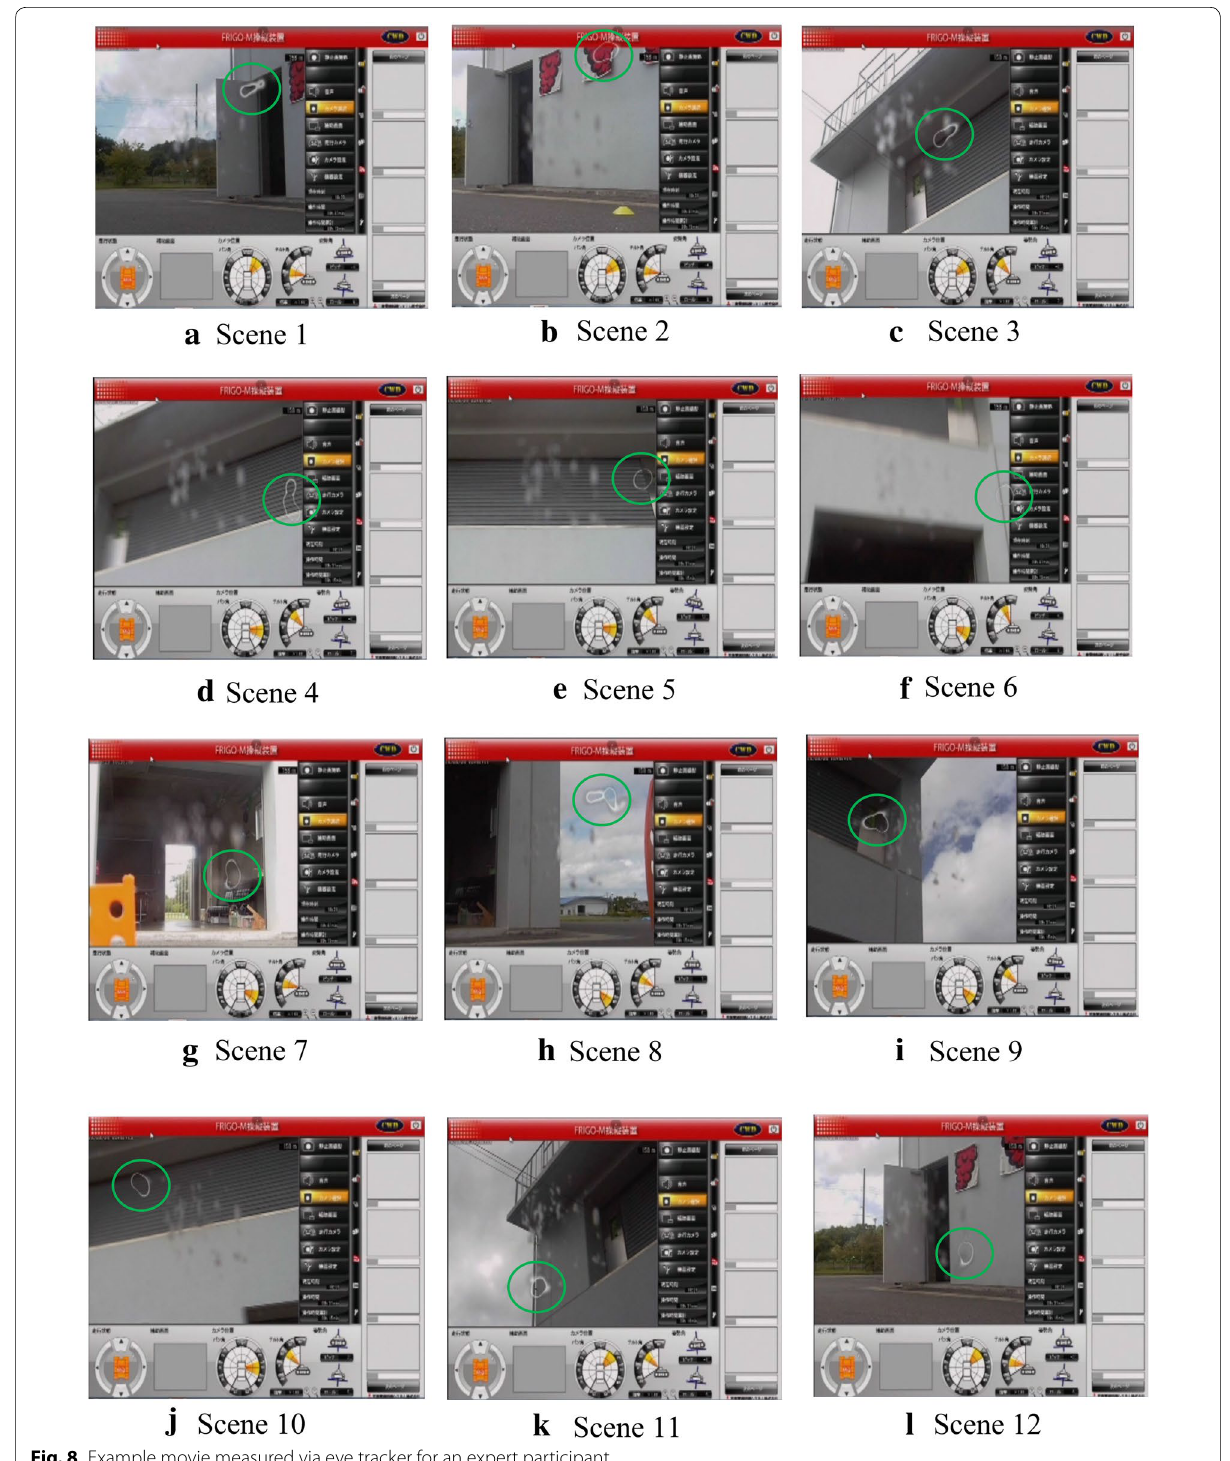
Fig. 8 Example movie measured via eye tracker for an expert